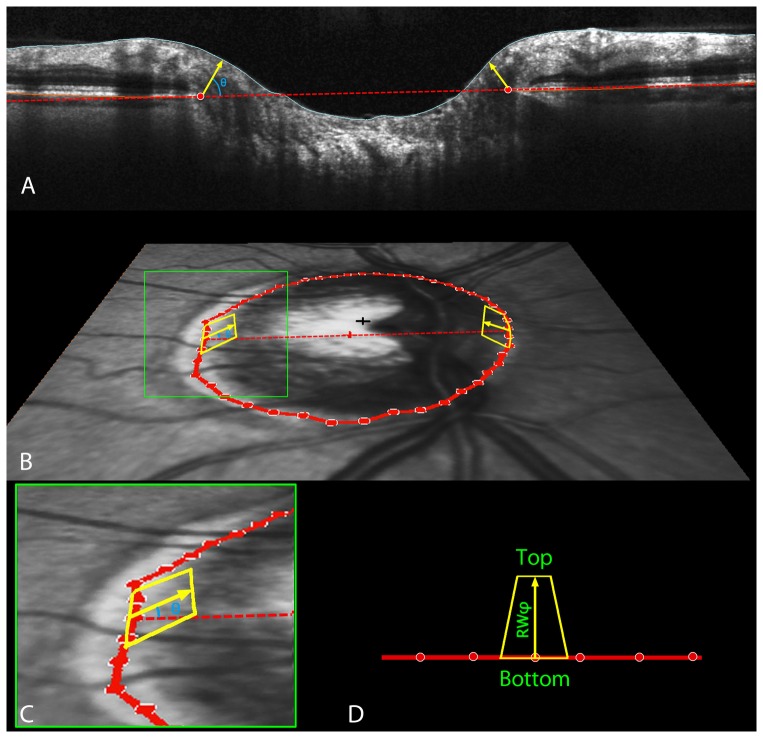
SDOCT ONH neuroretinal rim parameterization.A. Within each radial scan, Bruch's Membrane Opening (BMO) was delineated (red circles). The minimum rim width within that sector (MRWSec) was calculated, by finding the shortest distance from the BMO to the ILM (yellow arrow in Panel A). Within each section, the measures were averaged across sectors to give the sector measure BMO-MRW. This measure occurs at angle θ above the BMO plane (blue in Panels A and B, zoomed-in view in Panel C). Sectoral minimum rim areas (yellow areas in panels B, C and D) were calculated as the area of a trapezium at angle φ above the BMO plane (shown for simplicity as φ equaling θ, though this may not be the case for a given sector). The height of this trapezium was set equal to the rim width at this angle, . In the event that . The base of the trapezium (bounded by the BMO) equaled the BMO circumference within that sector, , where r represents the distance from BMO centroid (red cross in Panel B) to the BMO point. The top of the trapezium (bounded by the ILM) was calculated from these accounting for the inclination angle φ, giving length. The area of each trapezium is calculated using the formula:(Panel D).